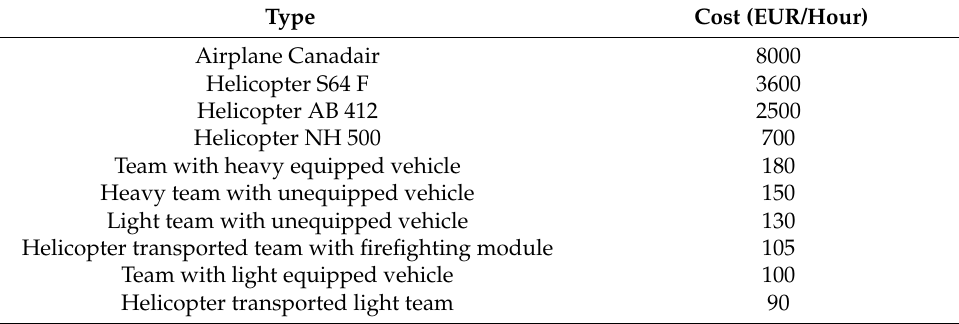
Table 1. Operating costs, by type, for wildfire suppression in the Mediterranean, 2021 [39]. Type